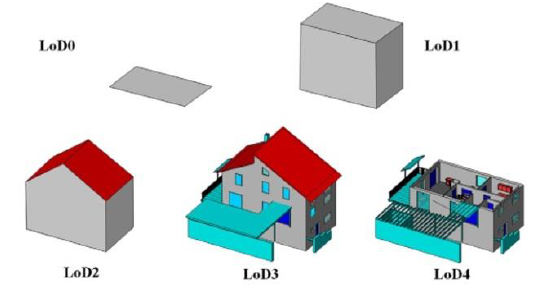
Figure 1: Five Levels of Detail (LoD) in CityGML (Gröger, Kolbe et al.,